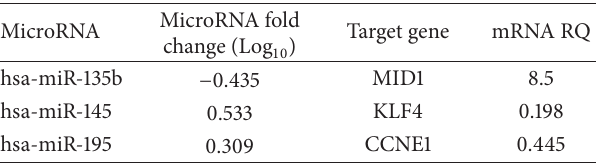
Table 1: Differentially regulated interaction between microRNAs and